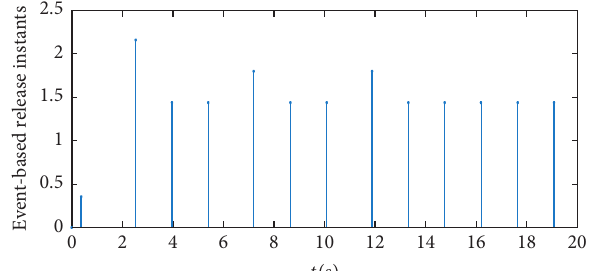
Figure 5: The release situation of state x 1 ( t ) under the improved distributed event-triggered scheme.